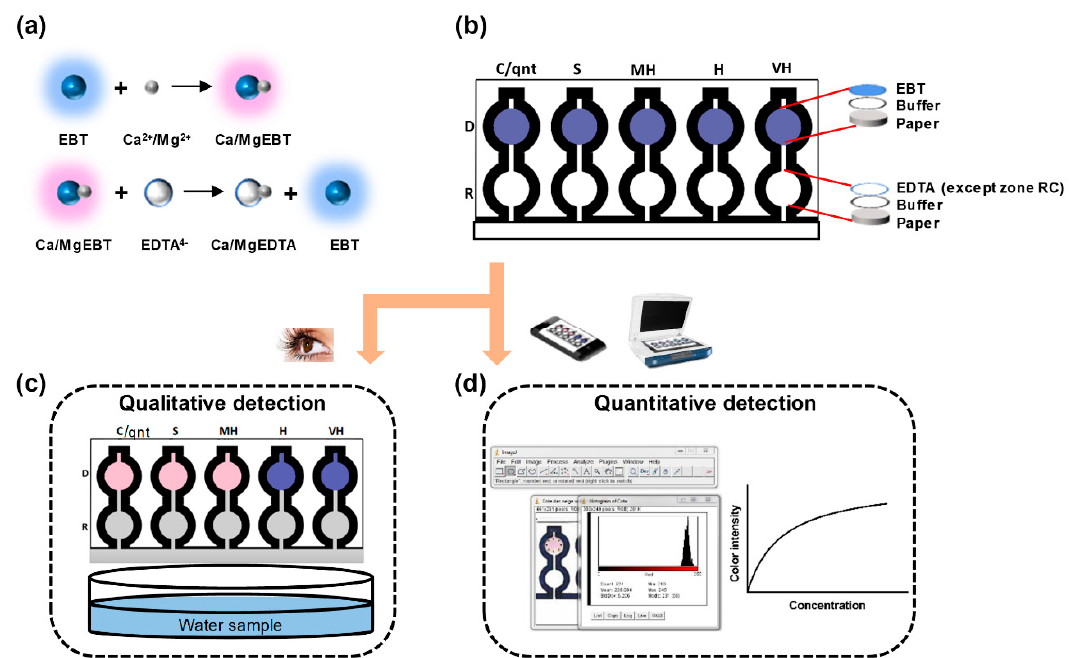
Figure 1. Schematic of the microfluidic paper-based analytical device (µPAD) for the detection of the total hardness of water. ( a ) The principle of the complexometric titration reactions; ( b ) the multi-layered deposition of the analytes on the µPAD; ( c ) the qualitative detection of the total hardness of water; ( d ) the quantitative detection of the total hardness of water.